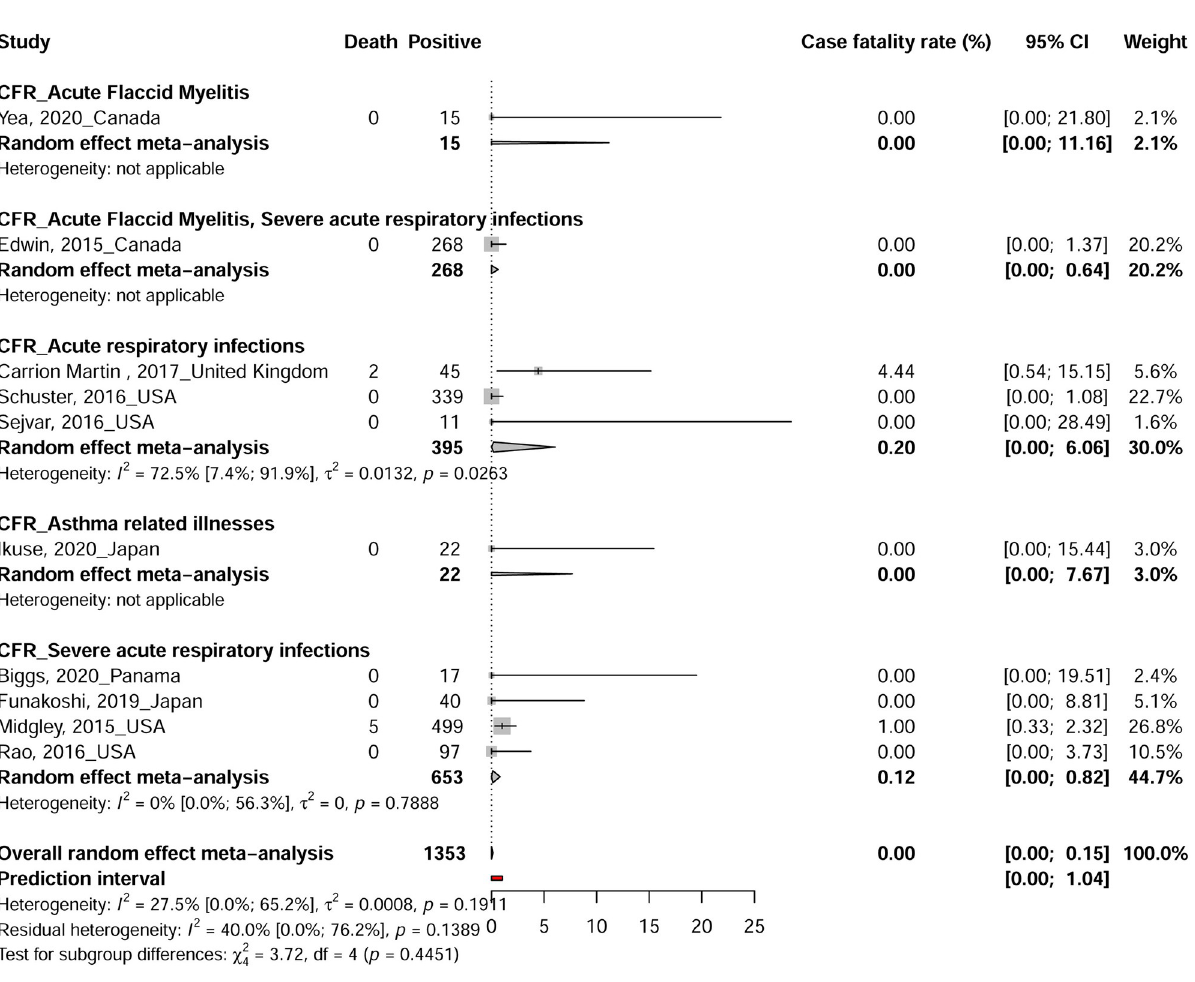
Fig 3. The pooled global case fatality rate of Enterovirus